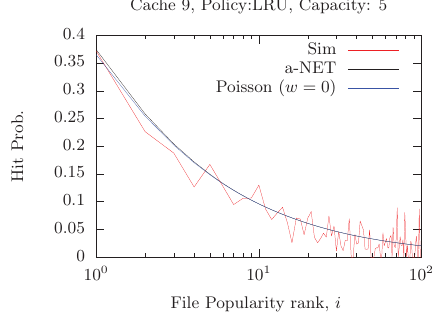
Figure 5: Simulations (Poisson arrivals Λ = 1 and Zipf popularity α = 0 . 7), Poisson approximation, and a-NET model on 10 caches random network. K = 100, C = 5.